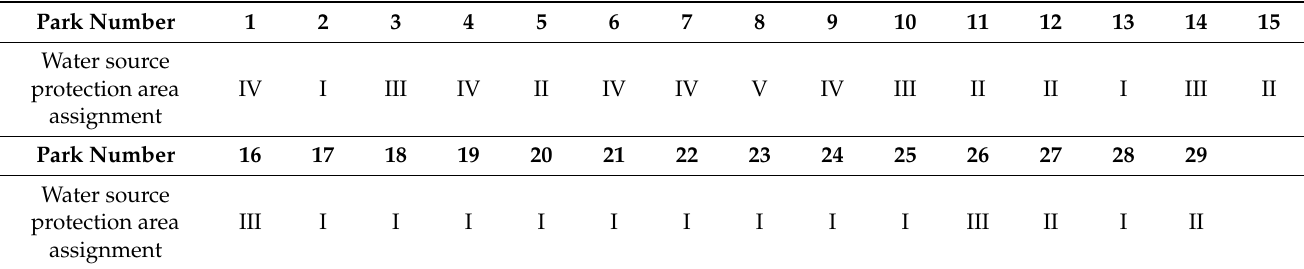
Table 11. The results of water source protection area of country parks.